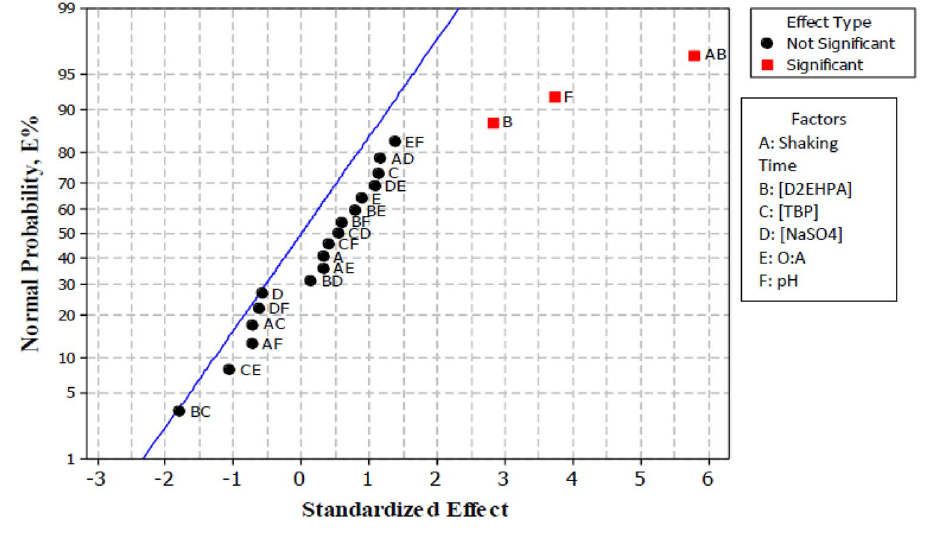
Fig. 6 Pareto chart for % E